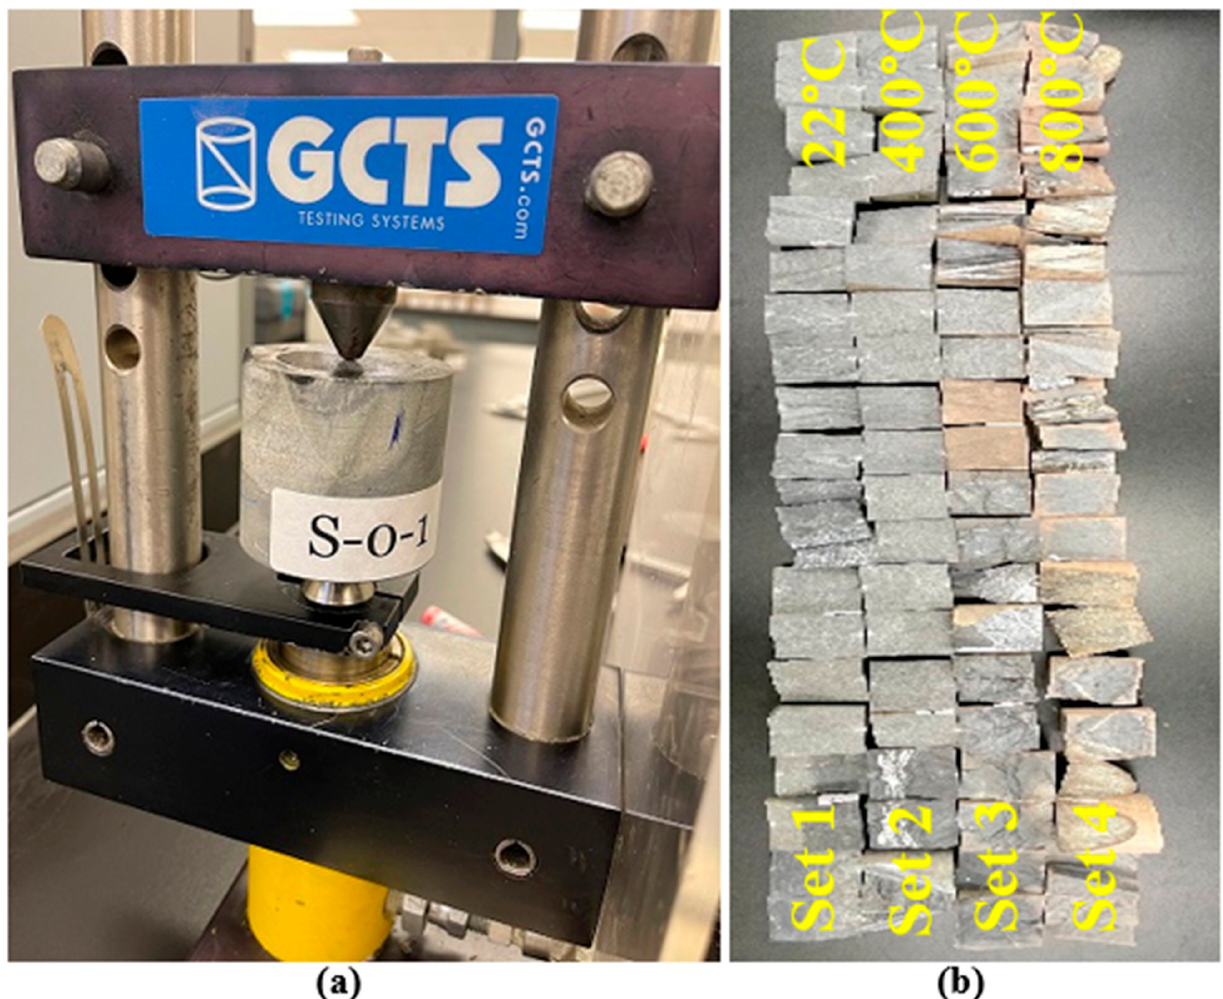
Figure 5. ( a ) Representative core samples during the point load test; ( b ) samples after the point load test.